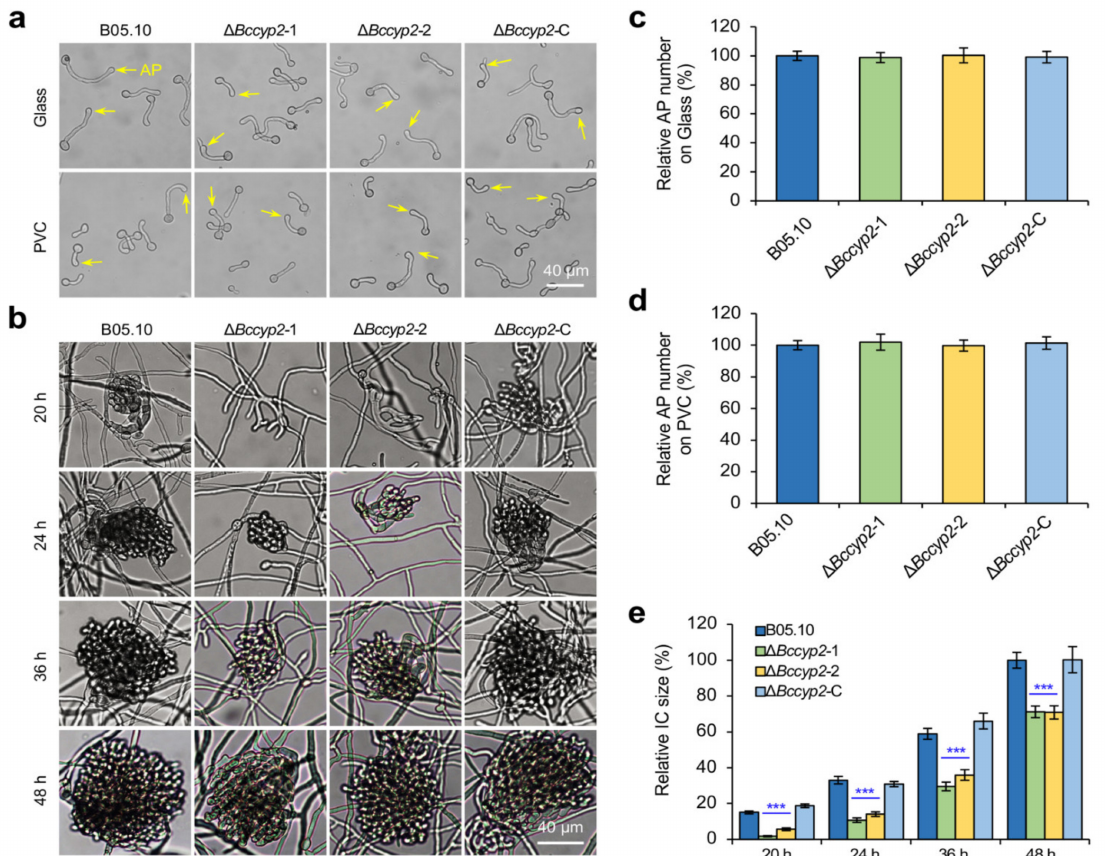
Figure 3. BcCYP2 plays an important role in infection cushion (IC) formation. ( a ) BcCYP2 is dispensable for B. cinerea appressorium formation. Conidia (5 × 10 5 conidia/mL in 1 liquid CM, 20 µ L) of the indicated strains were inoculated 2 on glass slides or PVC sheets and cultured at 20 ◦ C. At 7 h post-inoculation/incubation (hpi), appressorium formation by the tested strains was observed and documented. ( b ) Loss of BcCYP2 delays the development of ICs. Conidia (1 × 10 5 conidia/mL in 1 liquid CM, 20 µ L) of the indicated strains were inoculated on glass slides and cultured at 20 ◦ C. 2 ICs were photographically documented at 20, 24, 36, and 48 hpi. Images from a single representative experiment are presented. ( c , d ) Quantitative analysis of the relative number of appressoria produced by the tested strains on glass slides ( c ) or PVC sheets ( d ). ( e ) Quantification of the sizes of ICs produced by the tested strains. Data represent means ± SD from three independent experiments in which triplicate slides were examined for each strain in each experiment. ***: significance at p < 0.001. AP: Appressorium; PVC: Polyvinyl chloride